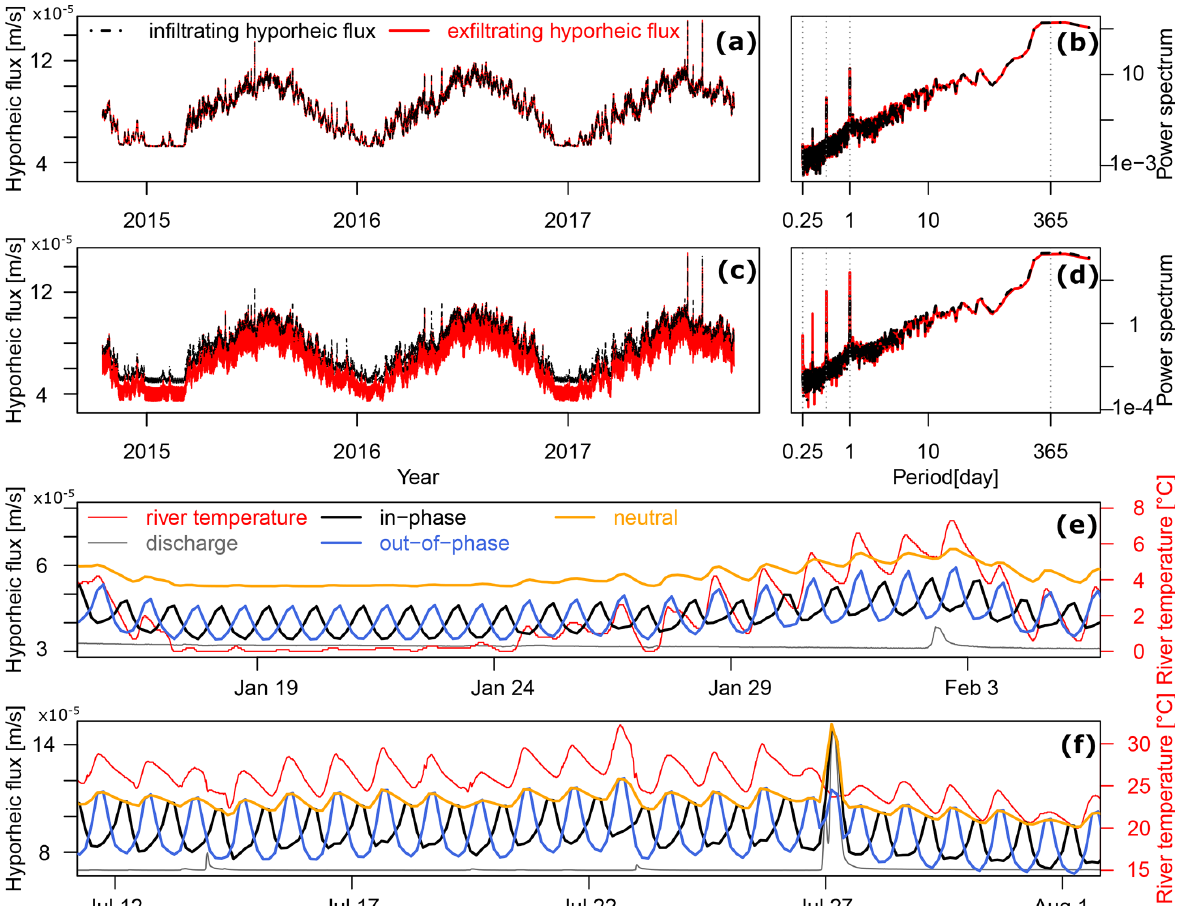
Figure 3. Effect of diel river temperature fluctuations and daily groundwater table drawdowns on hyporheic fluxes under gaining conditions. Infiltrating and exfiltrating hyporheic fluxes under (a) neutral and (c) gaining conditions. Power spectrum of infiltrating and exfiltrating hyporheic fluxes under (b) neutral and (d) gaining conditions. Exfiltrating hyporheic fluxes under neutral conditions and under gaining conditions with in-phase and out-of-phase groundwater drawdown scenarios in (e) winter and (f) summer. For figure clarity, discharge is not scaled in (e) and (f) but used only for qualitative comparisons. The flood event on 27 July causes a discharge increase from 2 to 1500m 3 s − 1